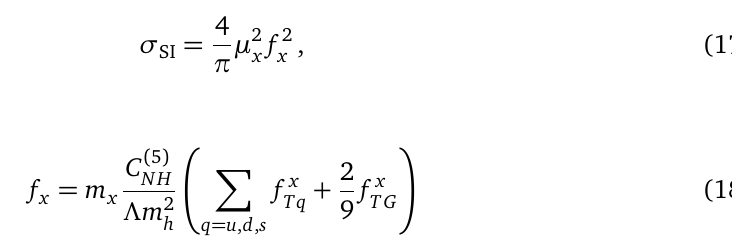
Figure 2: Direct detection constraints from XENON1T [ 54 ] on the operator introduced in Eq.(7). The area is excluded at 90%